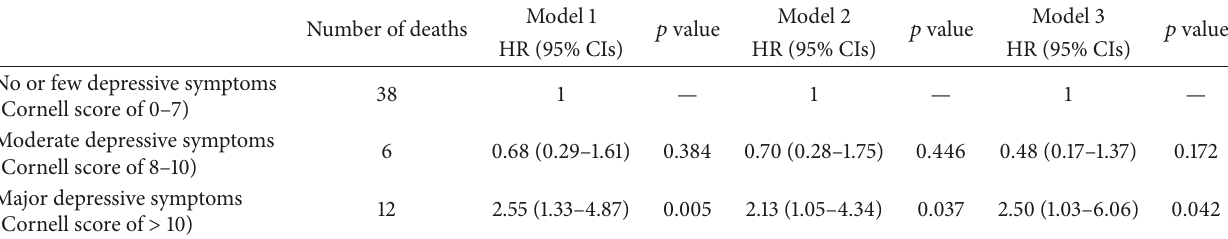
Table 2: The association of depressive symptoms with mortality in patients with mild